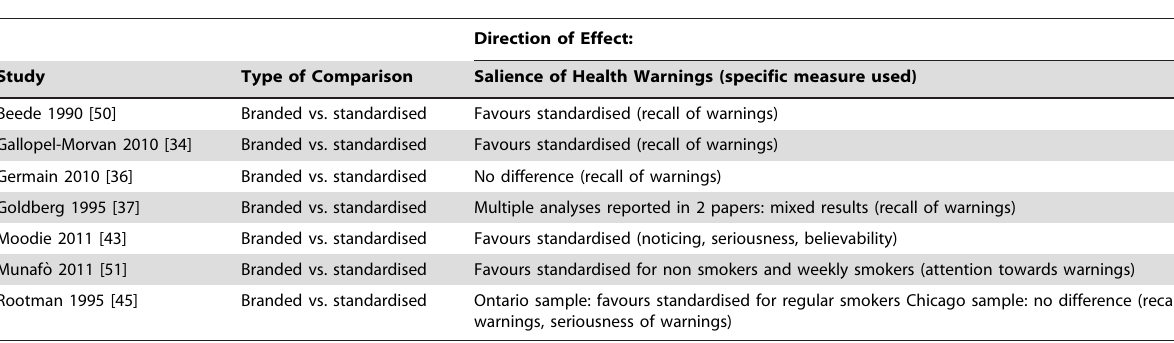
Table 2. Direction of effect: Salience of health